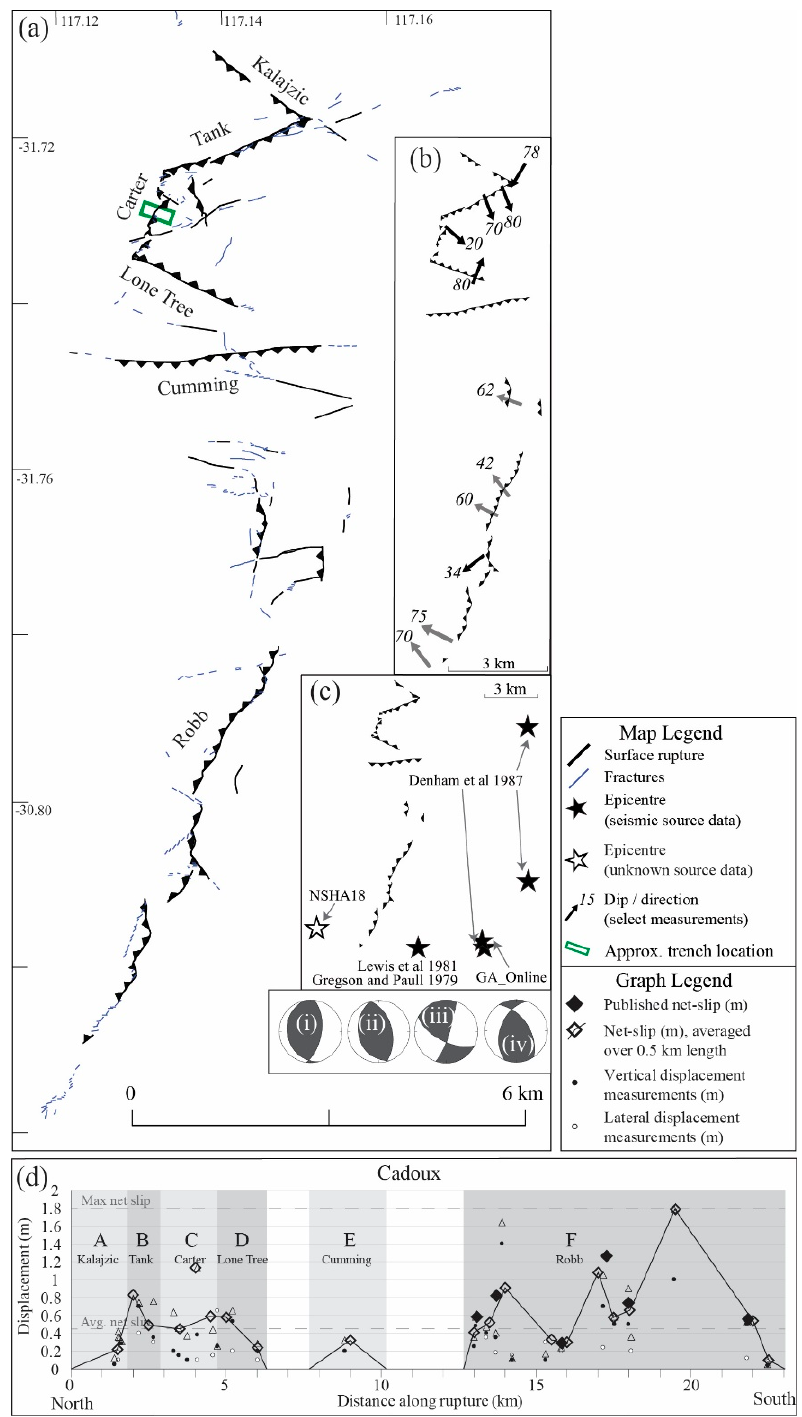
Figure 5. 1979 Mw 6.1 Cadoux earthquake ( a ) rupture scarps and fracturing involved in the Cadoux rupture with named faults [41], focal mechanisms from (i) Denham et al., 1987 (ii) Fredrich et al., 1988 (iii) Everingham and Smith (unpublished, Lewis et al., 1981) (iv) CMT ( b ) available dip measurements, black where directly measured and grey were calculated based on available displacement measurements [41] ( c ) published epicenter locations ( d ) graph along-rupture of vertical and lateral displacement measurements and calculated net slip [41] and net slip calculated from available data averaged over 0.5 km increments (this study).